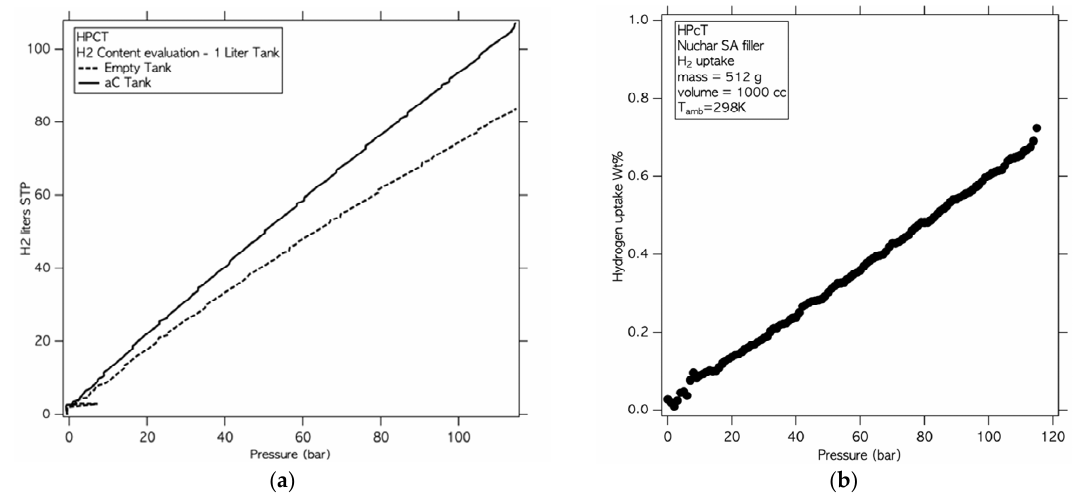
Figure 10. ( a ) Comparison of the stored hydrogen mass in the 0–12 MPa range (see text): absolute quantities uptake by the SSM powder; ( b ) Comparison of the stored hydrogen mass in the 0–12 MPa range (see text): net hydrogen uptake by the SSM powder.